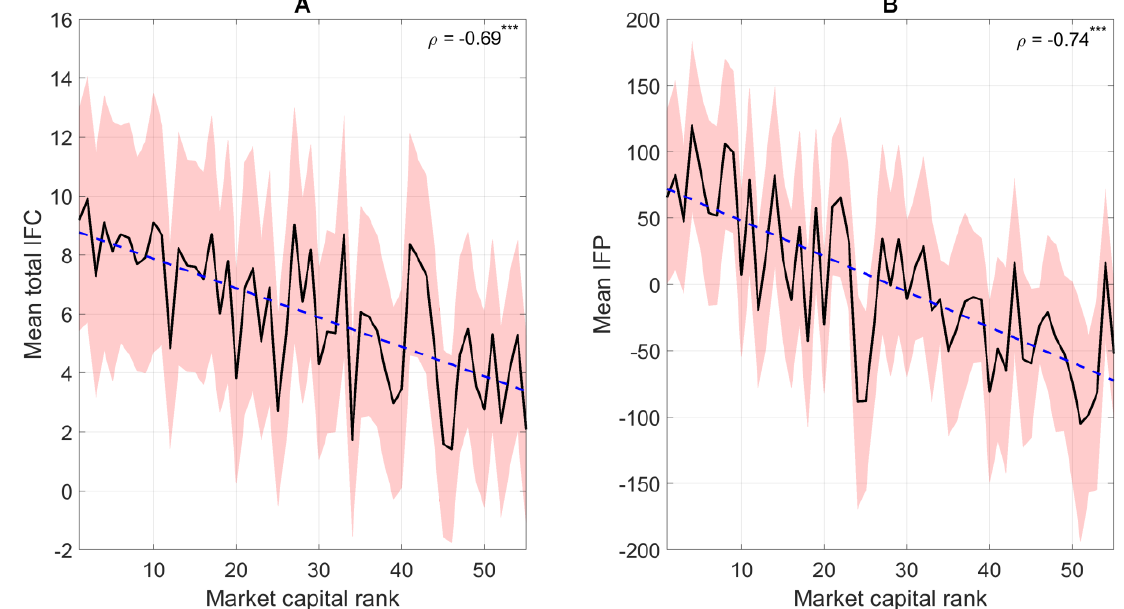
Fig 3A. Total iso-frequency coupling (IFC) vs. market capital rank. The total IFC mean ± std for each cryptocurrency along with the linear fit to the mean curve (mean total IFC = -0.1 × market capital rank + 8.8) is shown. 3B. Mean iso-frequency coupling phase (IFP) vs. market capital rank. The grand mean ± std of IFC phases for each cryptocurrency along with the linear fit to the mean curve (grand mean IFP = -2.7 × market capital rank + 74.7) is shown. Phase values are in degrees and range from -180 to +180. (mean ± std = black curve ± red shaded region; linear fit = blue dashed line; *** p <